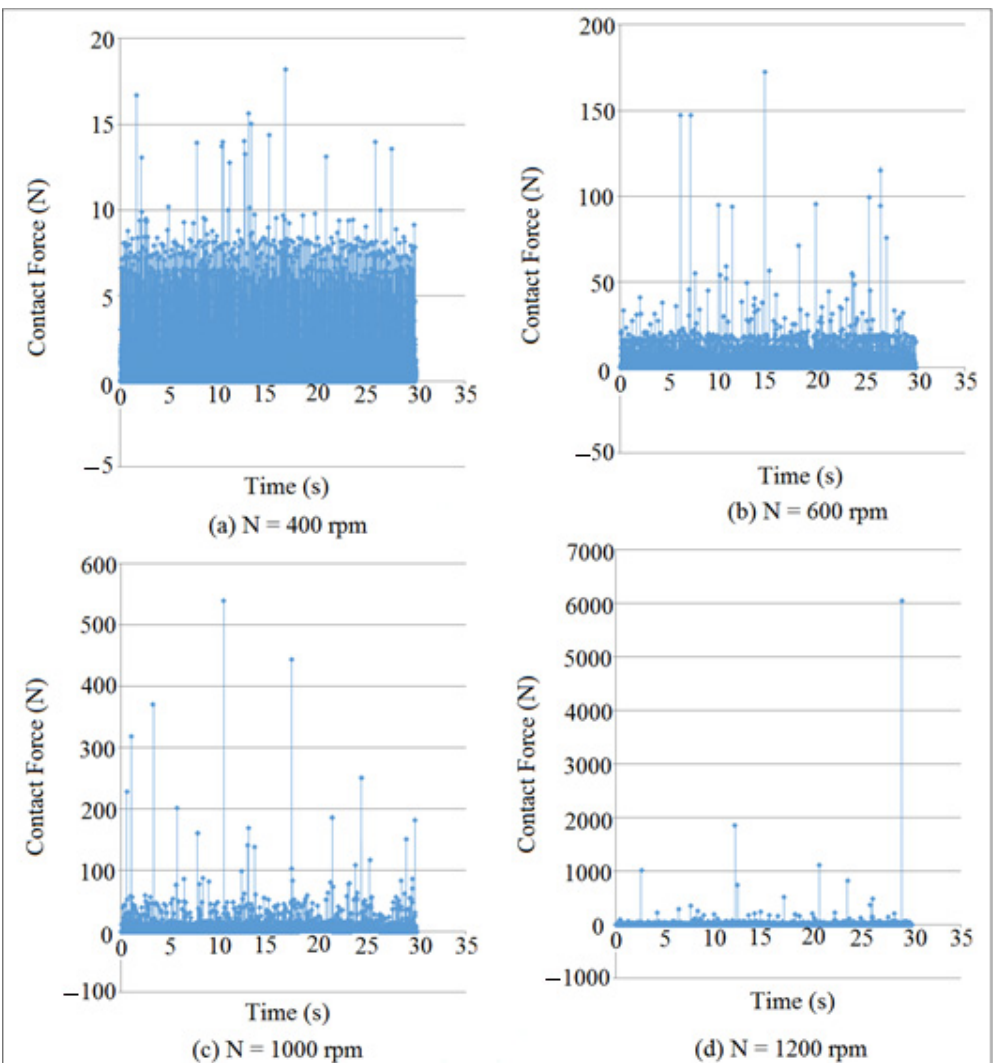
Figure 14. Contact force mapping against time at different cam speeds for (I.D. = 16 mm).